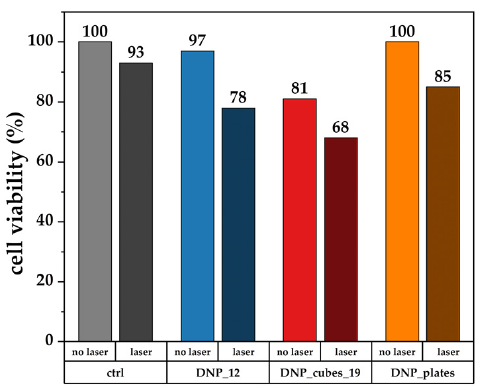
Figure 15. FaDu cell viability measured by the MTT test 24 h after 5 min of irradiation with a 1064 nm laser of 1 W/cm 2 . Cells were either incubated with no DNPs (control, ctrl) or with 100 µg/mL of DNP_12, DNP_cubes_19, and DNP_plates.